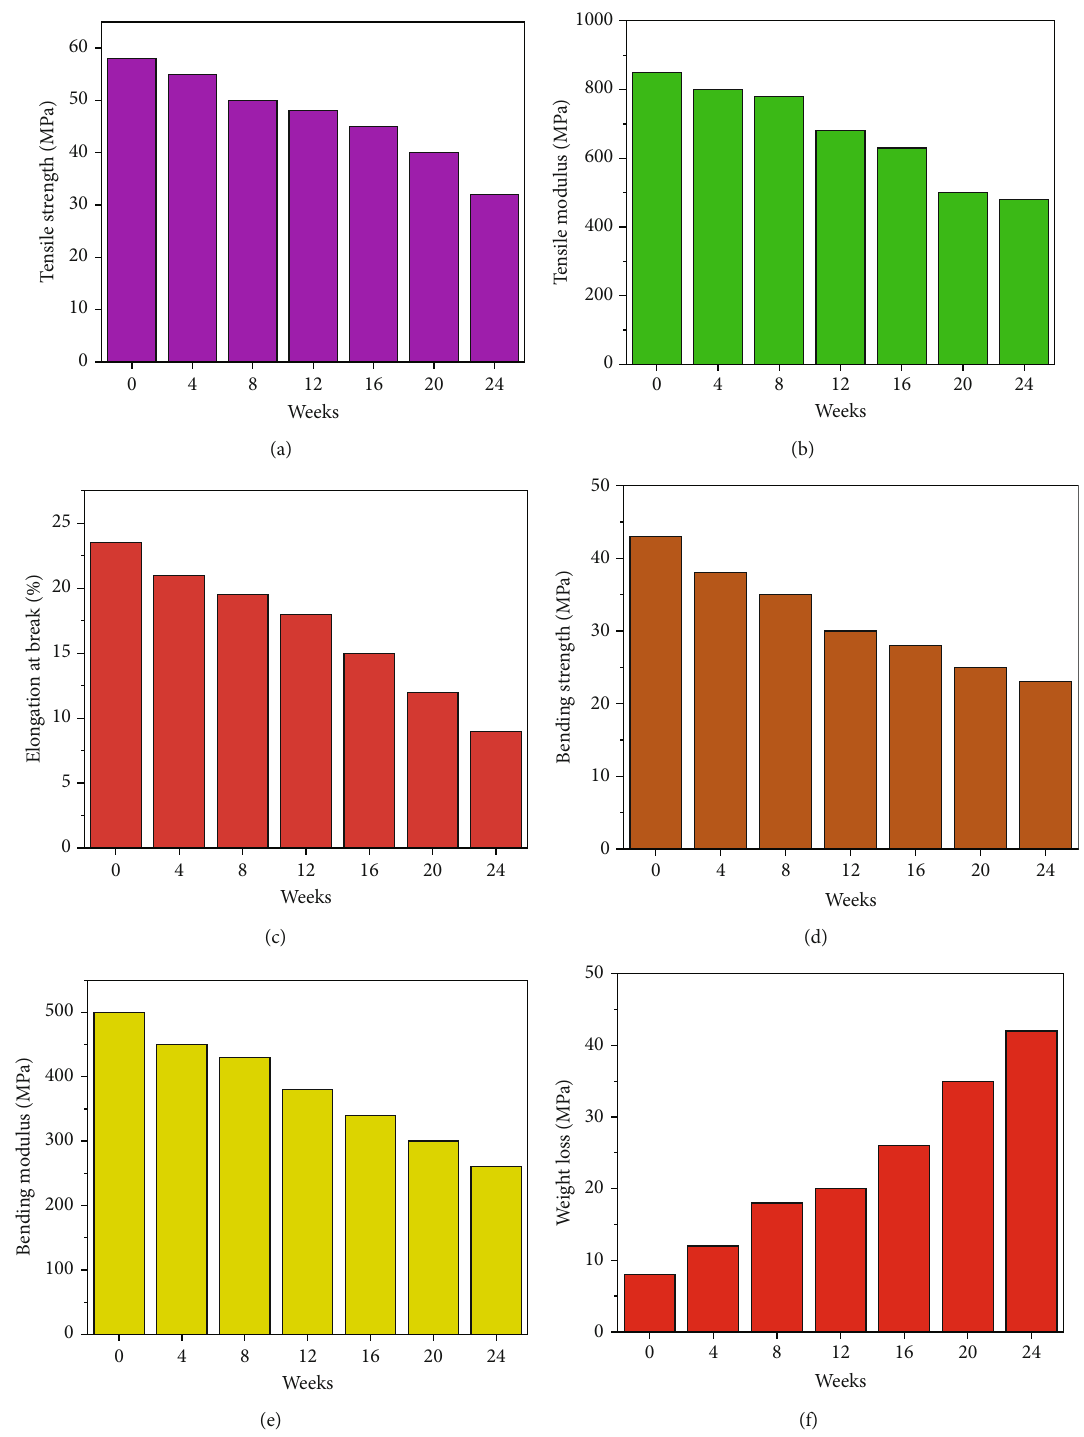
Figure 5: A soil degradation testing of the composites: (a) tensile strength, (b) tensile modulus, (c) elongation, (d) bending strength, (e) bending modulus, and (f) weight